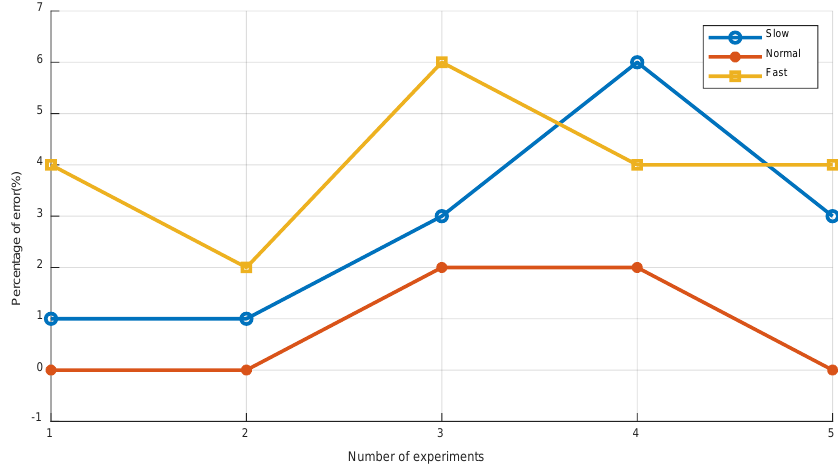
Figure 9. Step number error at different walking speeds.